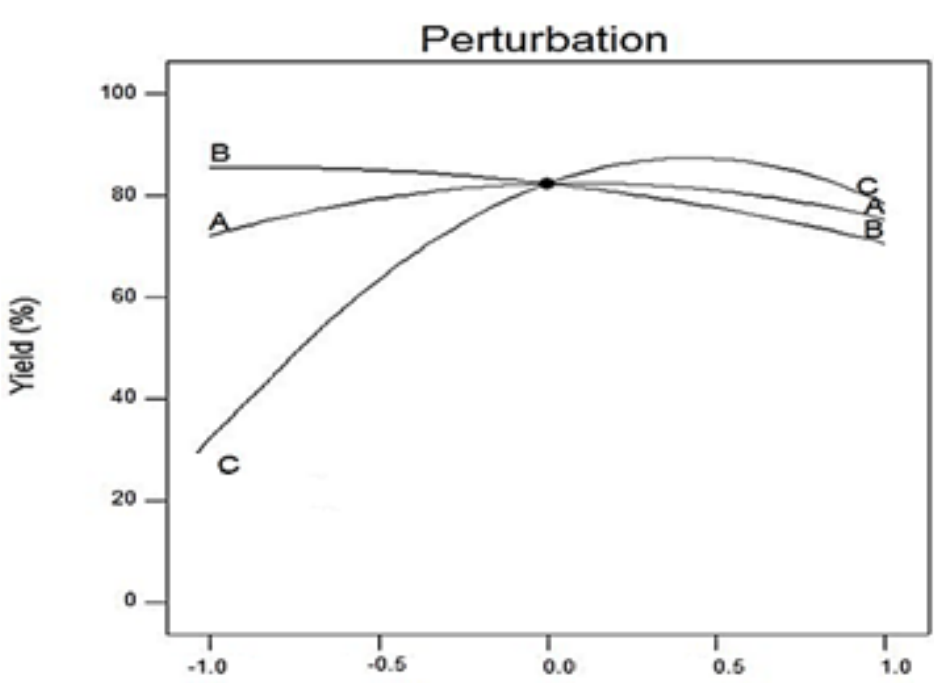
Figure 3. Effect of CC, Rt and methanol/oil ratio on yield (%) .